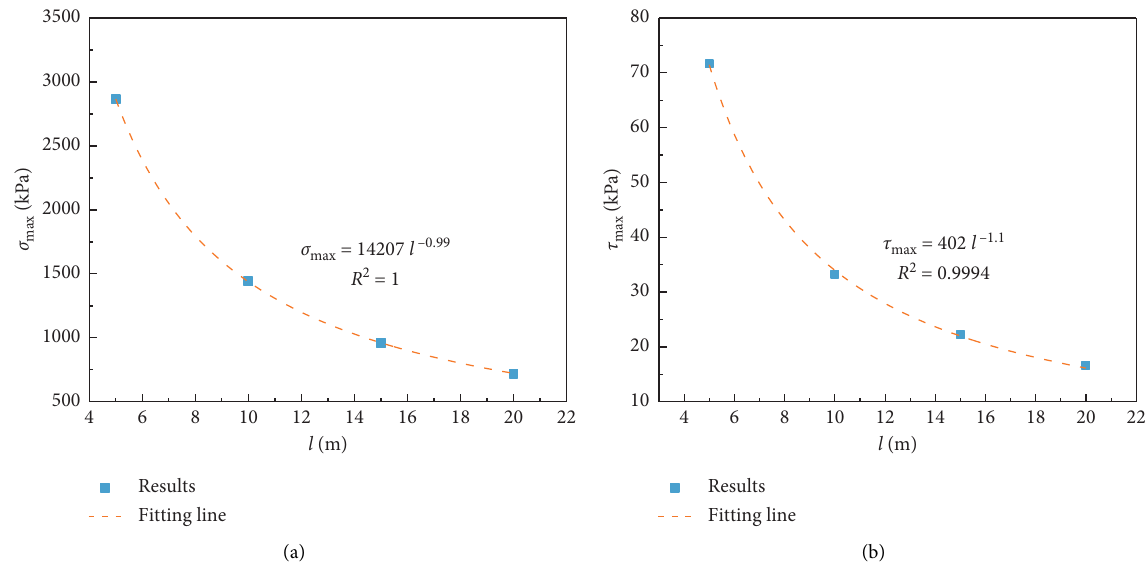
Figure 9: Effects of different transition lengths on the maximum normal stress (a) and maximum shear stress (b) of the dangerous